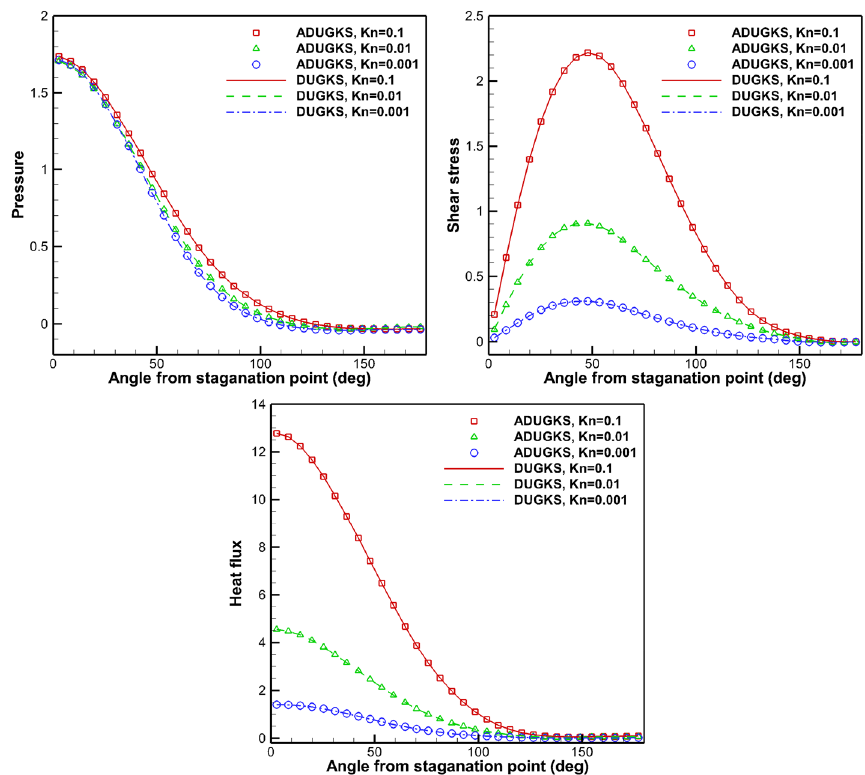
Fig. 18 Comparison of pressure coefficient, shear stress coefficient and normal heat flux distributions along the cylindrical wall from the stagnation point to the trailing edge at different Knudsen